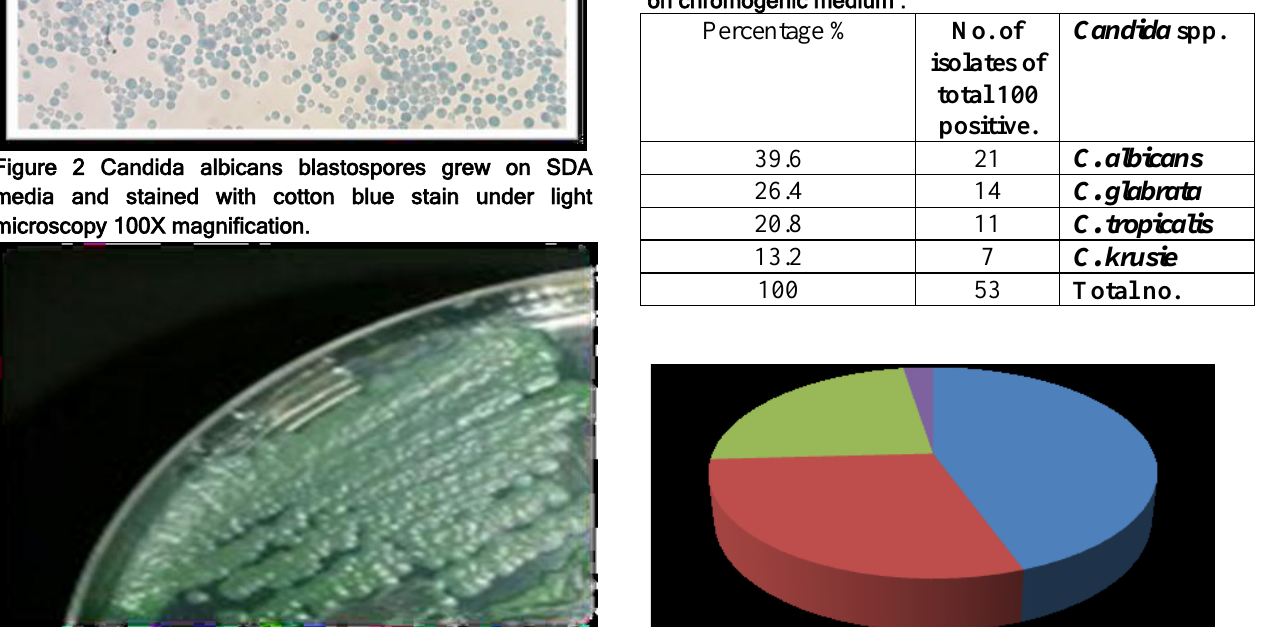
Figure-3- Candida Differential medium green colonies on HiCrome albicans C.